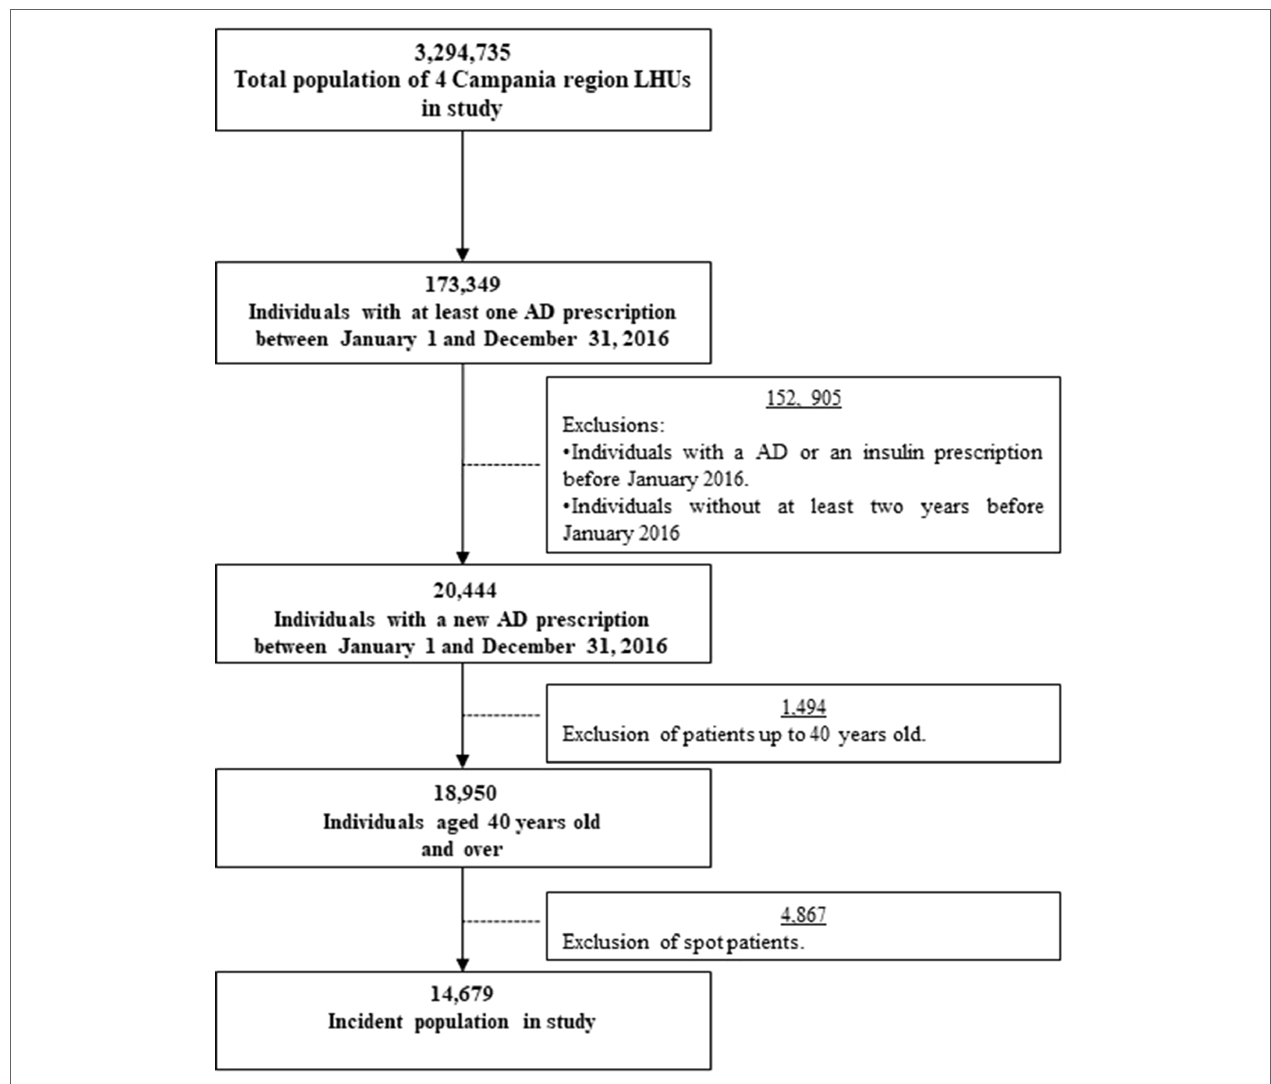
FIGURE 1 | Flow chart of the